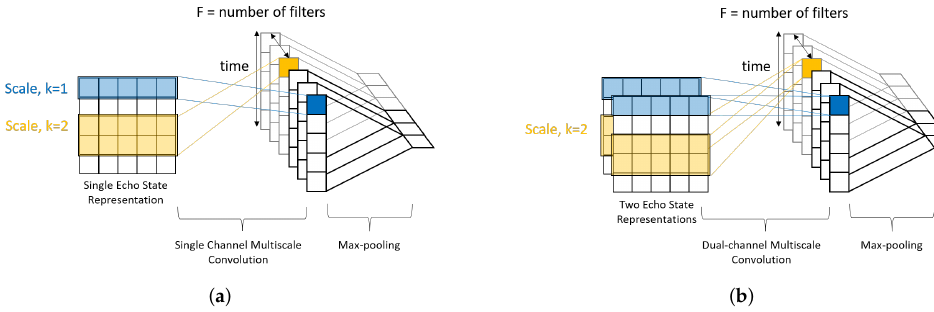
Figure 5. Multiscale convolution process extracts temporal features from ESR. ( a ) Single channel convolution is used for CT channel; ( b ) Dual-Channel Convolution is used for LA and RA as well as LL and RL